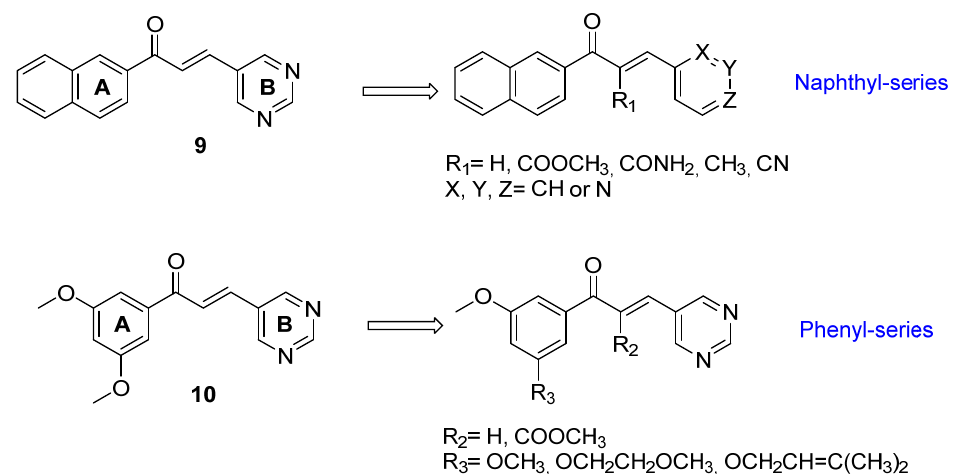
Figure 3. Chalcones synthesized and tested in this study as XPO1 inhibitors.